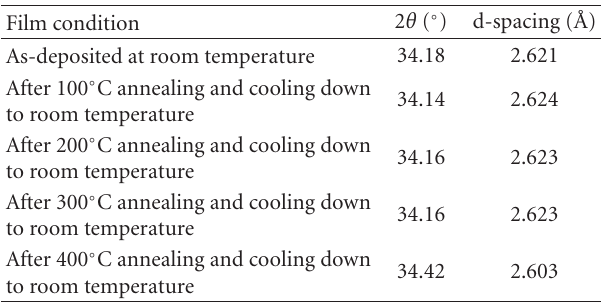
Table 2: The d-spacing between (002) planes in AZO films under di ff erent conditions.